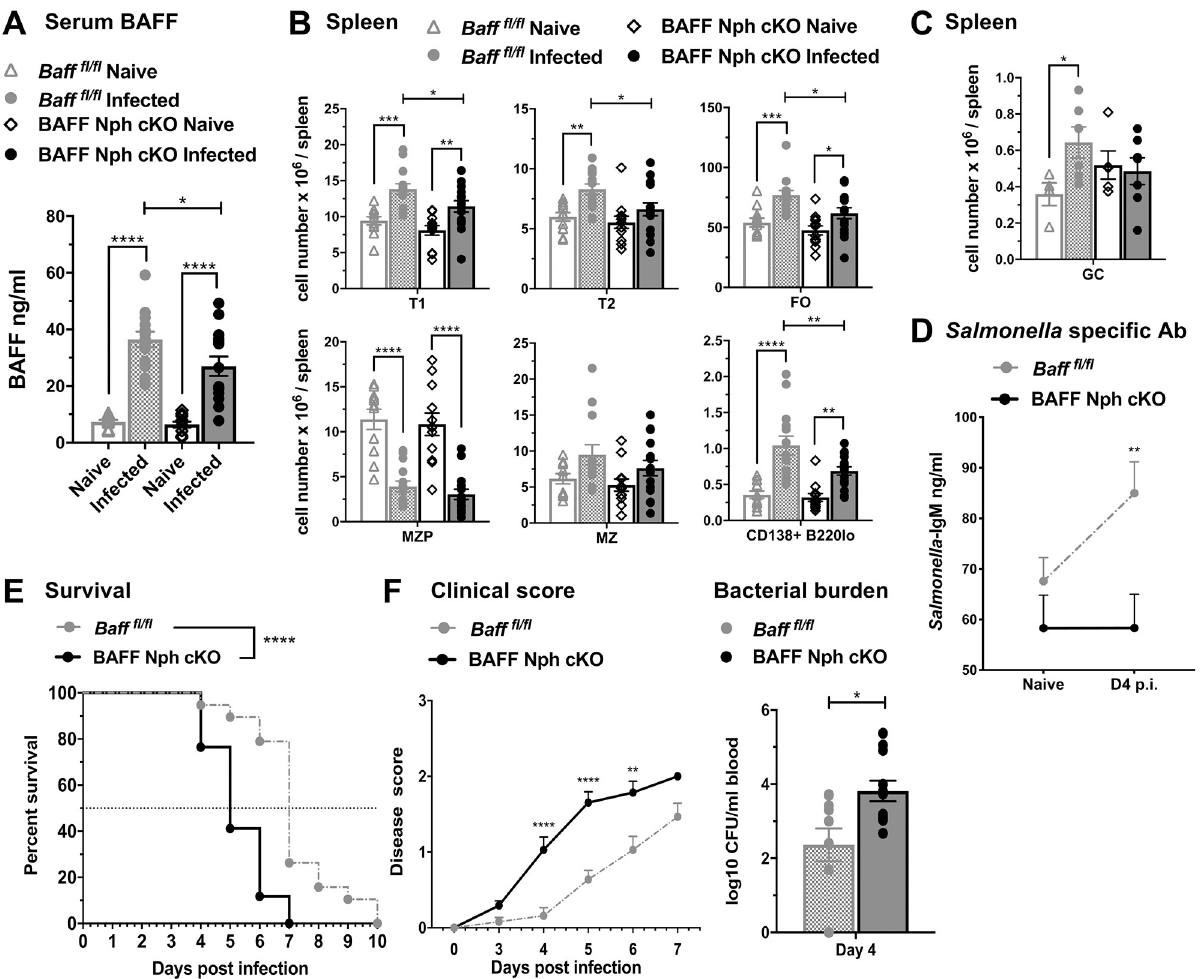
Fig 6. BAFF from Nphs is required for protective immune responses to S . typhimurium infection. (A-C) Baff fl/fl and Baff fl/fl MRP8 Cre (BAFF Nph cKO) mice were infected i.p. with 500 CFU S . typhimurium . Serum (A) and spleens (B and C) were harvested from na ï ve mice and mice infected for 4 days. (A) BAFF titers in the serum were measured by ELISA. (B and C) Absolute numbers of total splenic B cell subsets (T1, T2, FO, MZP, MZ and B220lo CD138 + plasma cells) (B) and GC B cells (C) were analyzed by flow cytometry. (A and B) Data are combined from four independent experiments (n = 11–15). (C) Data are combined from two independent experiments (n = 4–6). (D-F) Baff fl/fl and BAFF Nph cKO mice were infected i. p. with 25 CFU S . typhimurium . (D) Salmonella specific IgM Abs in the serum were analyzed by ELISA. Data shown in (D) are combined from three independent experiments (n = 17–24). (E-F) Data show survival (E), clinical scores (F, left panel ) and bacterial burdens (F, right panel ) measured at day 4 p.i. by plating blood collected via the retro-orbital route. (E and F, left panel ) Survival and clinical scores data are combined from three independent experiments: Baff fl/fl , n = 19; BAFF Nph cKO, n = 17. (F, right panel ) Data of bacterial burdens were summarized from two independent experiments (n = 10–11). (A-D) Statistics were determined by Two-Way Anova with Holm-Sidak multiple comparisons test. (E) Survival data were analyzed using a log-rank test for significance. (F, left panel ) Significance of clinical scores were determined by Two-Way Anova with Holm-Sidak’s multiple comparisons test. (F, right panel ) Unpaired Student t test was used to determine significance in bacterial burdens. Bar graphs show means ± SEM; � p < 0.05, �� p < 0.01, ��� p < 0.001, ���� p < 0.0001.